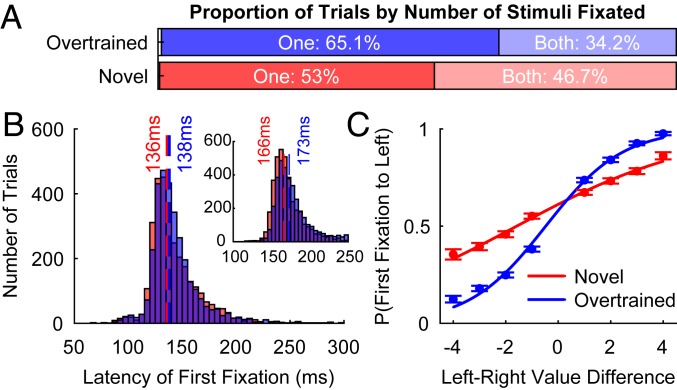
Subjects rapidly fixate more valuable stimuli. (A) The proportion of trials where subjects viewed 0, 1, or both stimuli. (B) Histograms of the latency with which subjects fixated the first stimulus in novel (red) and overtrained (blue) trials. Both subjects rapidly fixate a stimulus within ∼150 ms on most trials. The main plot displays data for subject M; the Inset shows data for subject F. Dashed vertical lines show the median latency per trial type. (C) The probability (±SE) of fixating the left stimulus first as a function of left–right stimulus value difference. First fixations were generally to the more valuable stimulus. This effect is stronger on overtrained than on novel trials. Lines show logistic model fits.